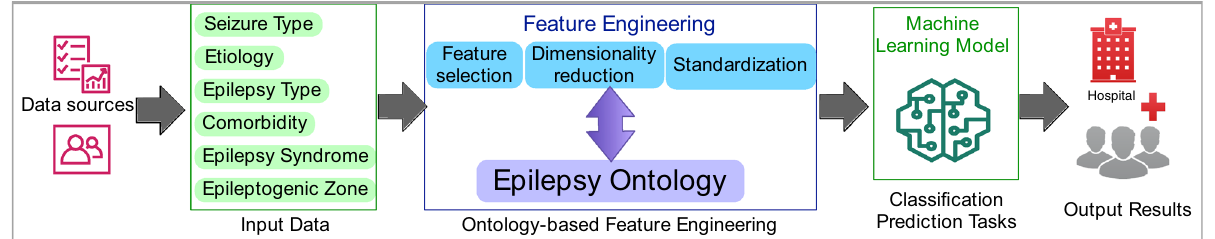
Figure 1. Visualization of a machine learning workflow and the role of epilepsy ontology in feature